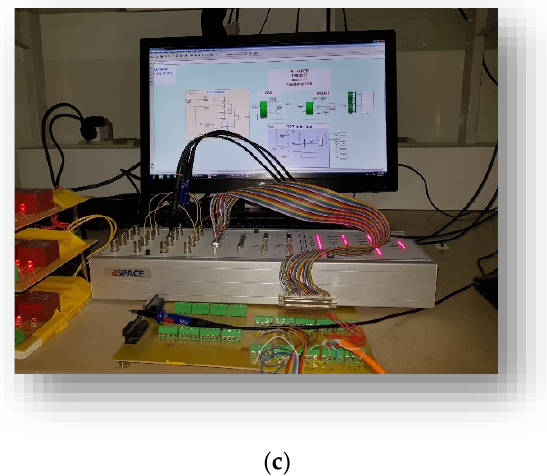
Figure 10. ( a ) Real circuit of the single-phase nonlinear load, ( b ) schematic diagram of the experimental setup, ( c ) real-time experimental setup.